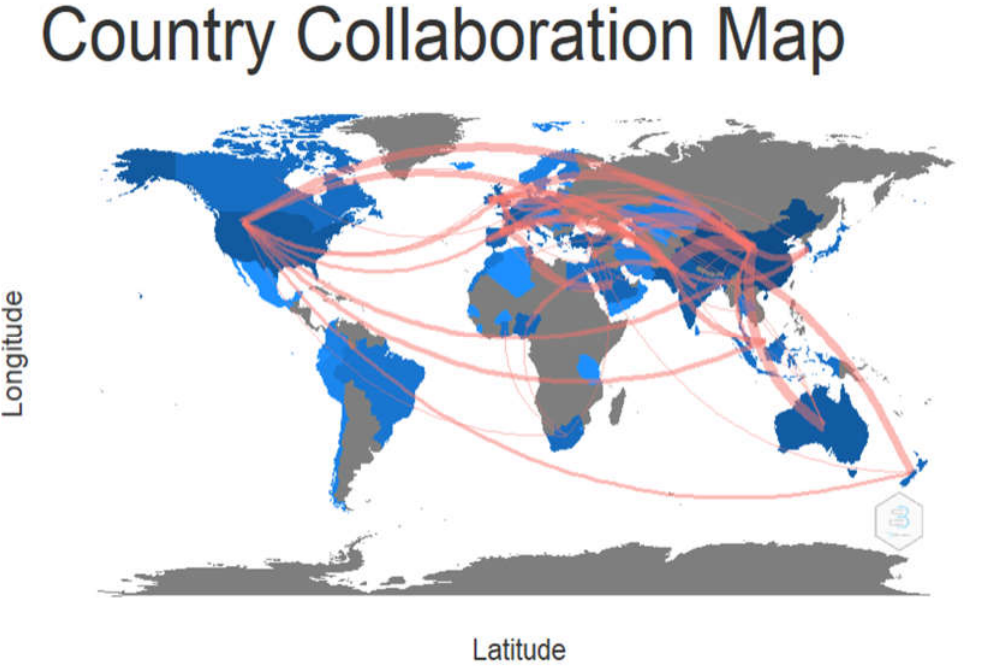
Figure 3. Thematic map. Source: Scopus/Biblioshiny.